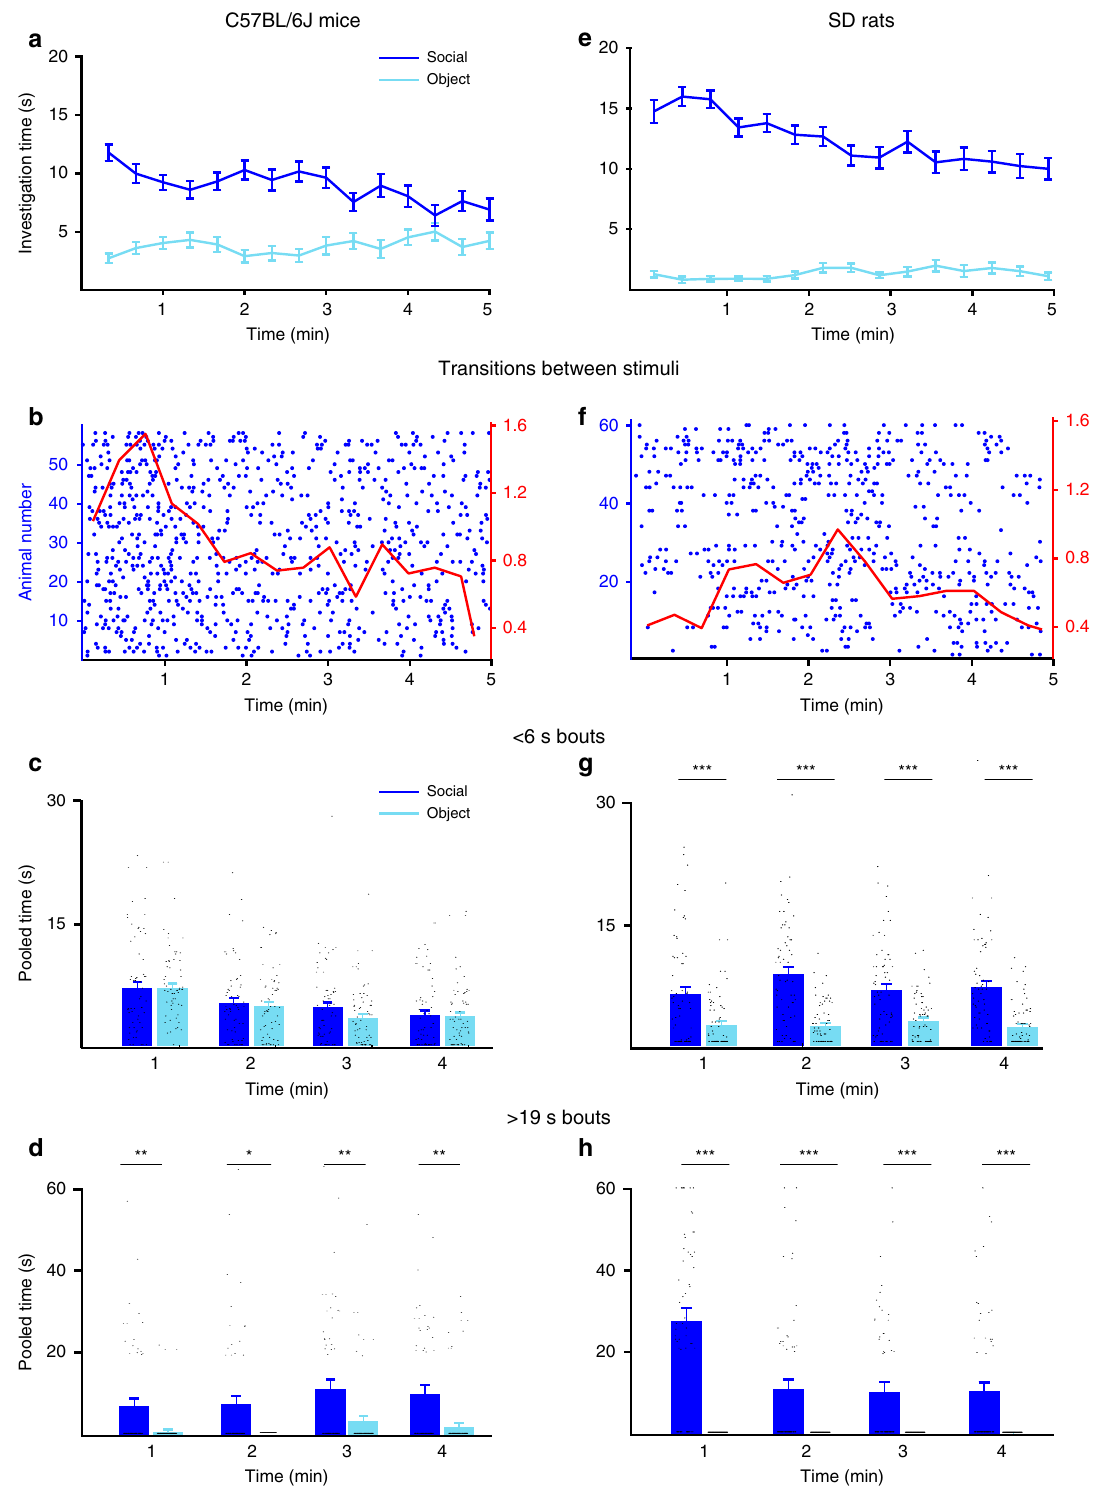
Fig. 1 Distinct social-preference (SP) dynamics of C57BL/6J mice and SD rats. a Mean investigation time of social and object stimuli, averaged in 20-s bins across time during the 5-min-long SP test conducted with C57BL/6J mice ( n = 58). b Transitions between the two stimuli, made by subject mice across time during the test. Each punctum denotes the beginning of investigation of a new stimulus, and each row represents a single subject. The mean rate (using 20-s bins) is denoted by the red line (right red y -axis). c Mean pooled time of short investigation bouts (<6 s) across time during the SP test of mice (using 1-min bins, last minute excluded; see “ Methods ” ). d As in c , when extended bouts (>19 s) are considered. Black lines at the bottom of the bars represent data points with a value of zero. e – h As in a – d , for SD rats ( n = 60). Black lines at the bottom of the bars represent data points with a value of zero. * p < 0.05, ** p < 0.01, *** p < 0.001, post hoc two-tail t test following the main effect. All error bars represent SEM. Source data are provided as a Source Data fi